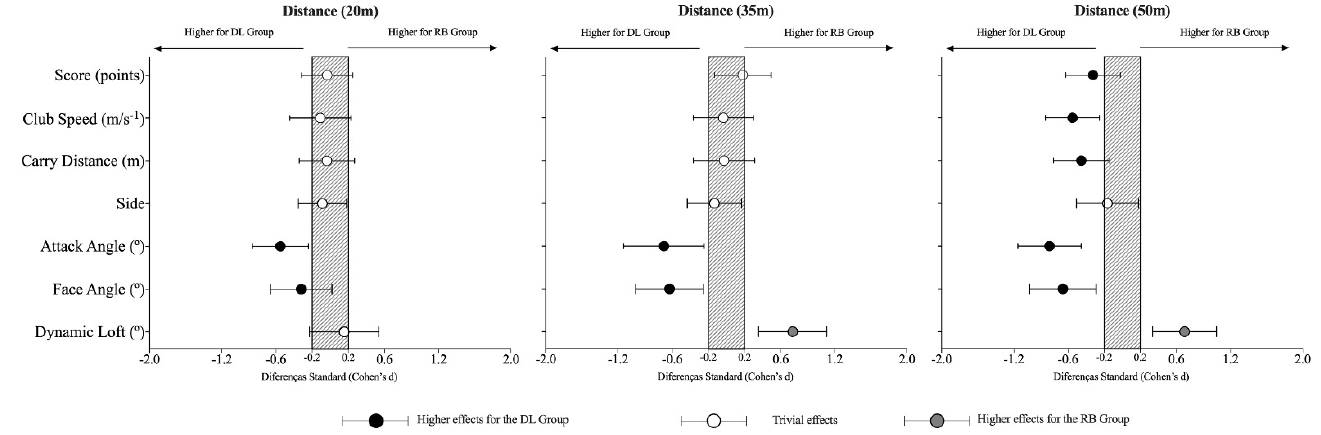
Figure 2. Standardized (Cohen) differences in golf shot performance for the different variables according to the distance and training intervention. Error bars indicate uncertainty in the true mean changes with 95% confidence intervals. DL = differential learning; RB = repetitive-based group; M = mean; SD = standard deviation.